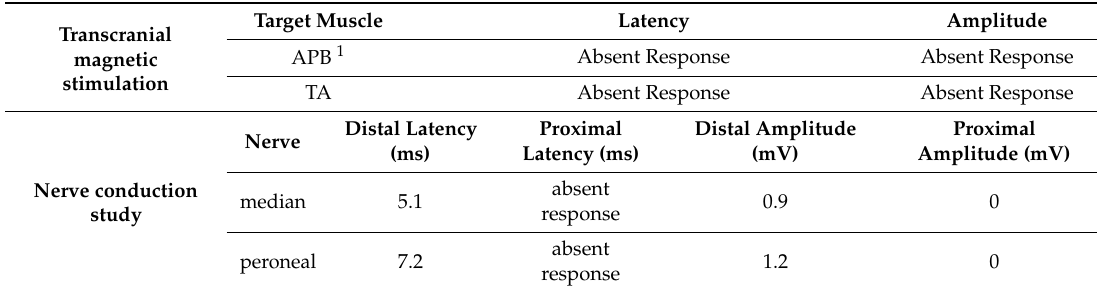
Table 3. Transcranial magnetic stimulation and motor nerve conduction studies for the